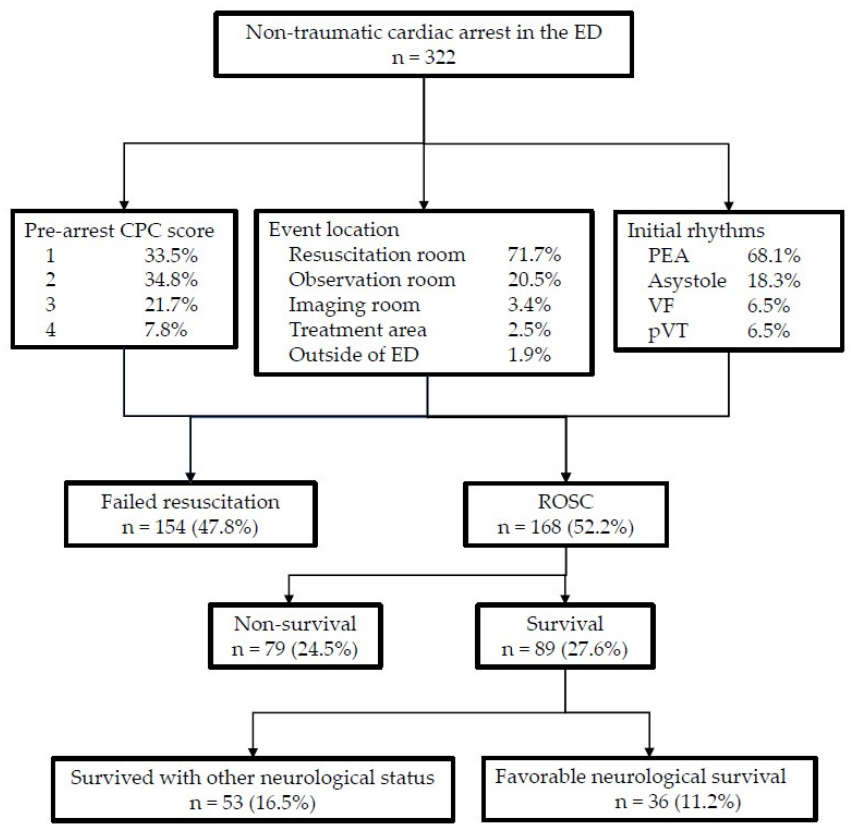
Figure 1. A flowchart of baseline characteristics and outcomes. Abbreviations: CPC: Cerebral performance category; ED: Emergency Department; PEA: pulseless electrical activity; VF: ventricular fibrillation; pVT: pulseless ventricular tachycardia; ROSC: return of spontaneous circulation. Survival of EDCA was associated with presence of preexisting conditions (heart fail- Table 1. Clinical characteristics and Utstein style elements of survival and non-survival IHCA patients. ure, myocardial infarct, hepatic failure, hypotension/shock, metabolic illnesses, diabetes mellitus, sepsis, and renal failure), non-respiratory causes of cardiac arrest, initial rhythm Patient Data of ventricular fibrillation or pulseless ventricular tachycardia, receiving coronary angiog- raphy (urgent or delayed), attempts of coronary reperfusion, and targeted temperature management (TTM). The cardiac arrest survival post-resuscitation in-hospital (CASPRI) score was also associated with survival, and the CASPRI scores were lower in the survival group (mean ± SD, 15.3 ± 6.4 vs. 19.4 ± 5.4, p < 0.001) (Table